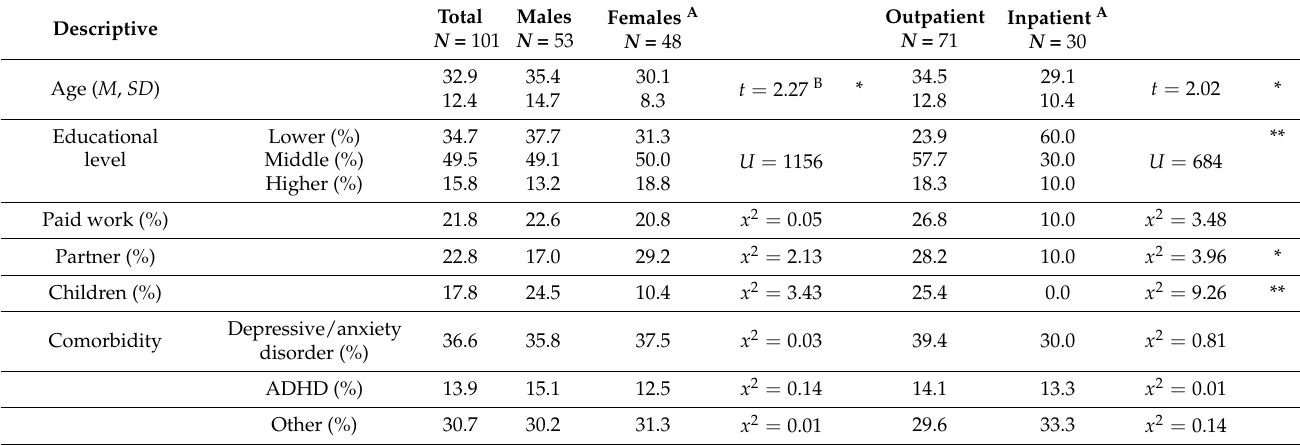
Table 1. General sample characteristics for total sample and by sex and treatment